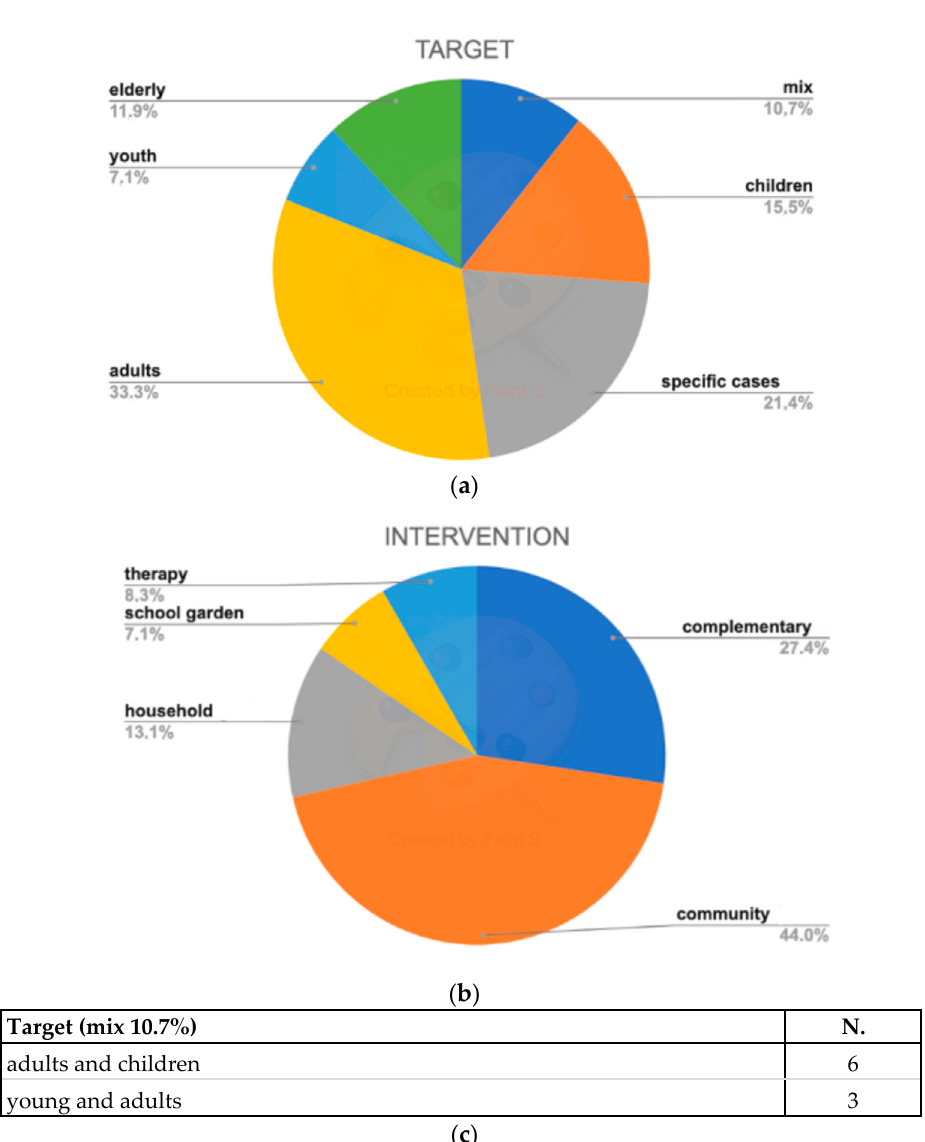
Figure 3. ( a ) Type of activity/intervention; ( b )Garden-based activities target to different groups. ( c ) details on the mixed age-groups.